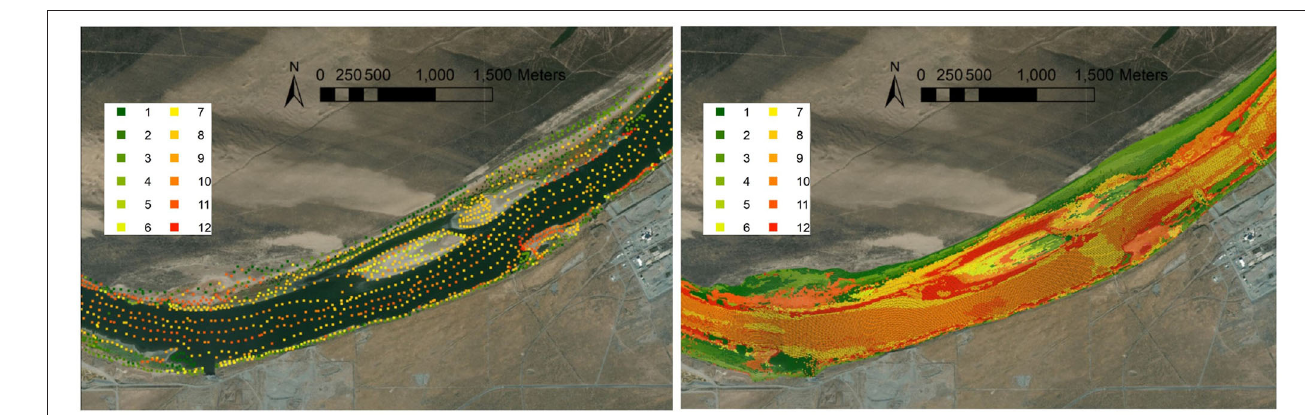
FIGURE 6 | The dominant substrate size distribution of 12 classes with smaller class number representing the smaller dominant substrate size. The left panel is the ground-truthing and the right panel is the model prediction for each simulation grid.